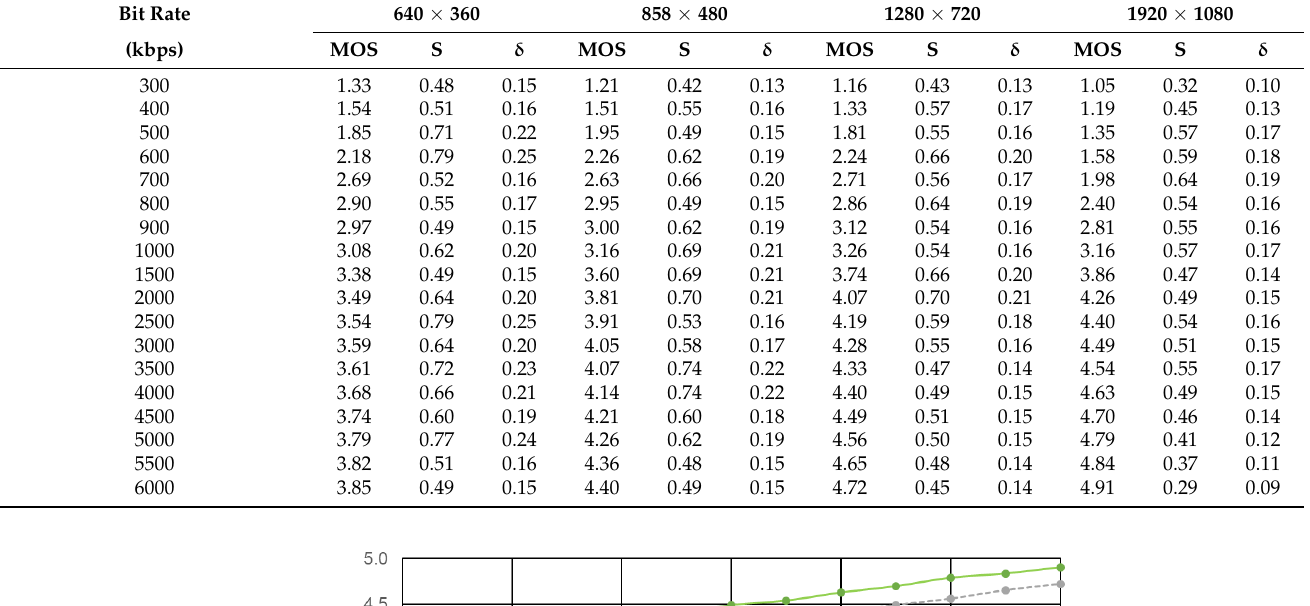
Table 2. Mean value of the video quality assessment (MOS) for H.264 codec, standard deviation (S), and confidence interval coefficient ( δ ) for four resolutions—measurements in laboratory.